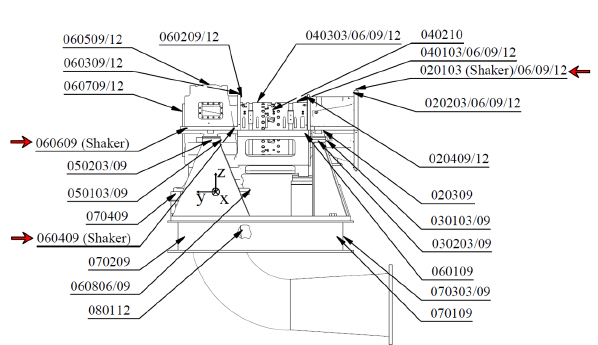
Figure 2. Acceleration sensor positions on axial compressor casing, cf. [20].